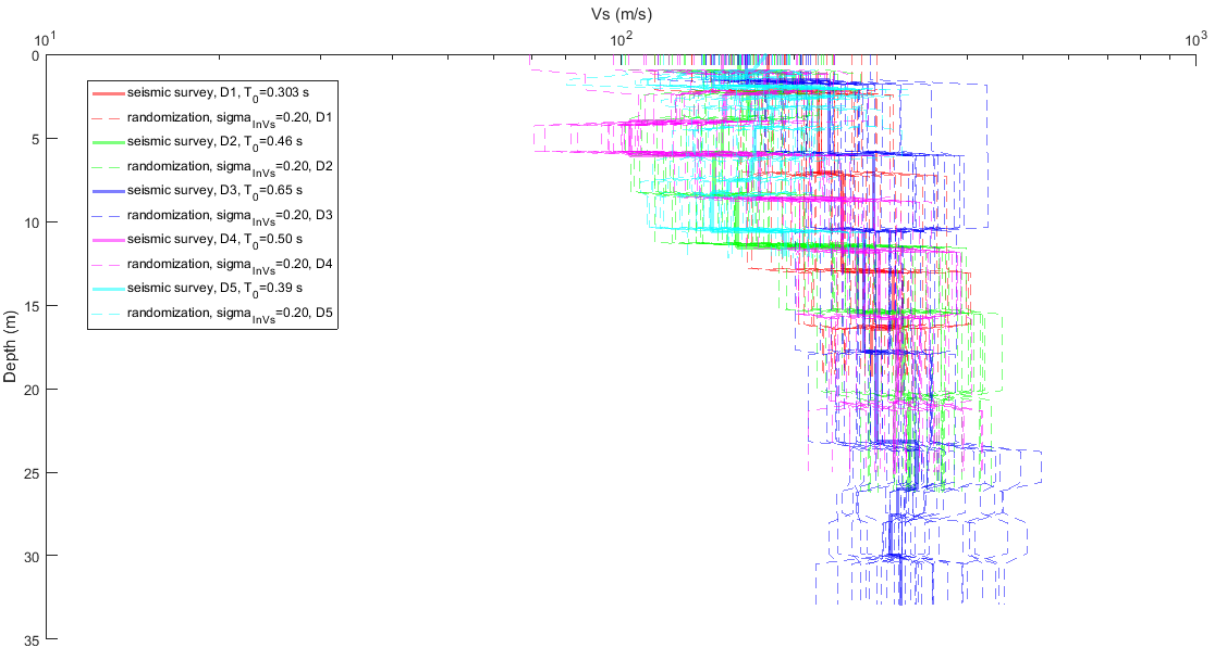
Figure 6. Randomized Vs profiles for the sites D1 to D5. T 0 is the fundamental period of the site.